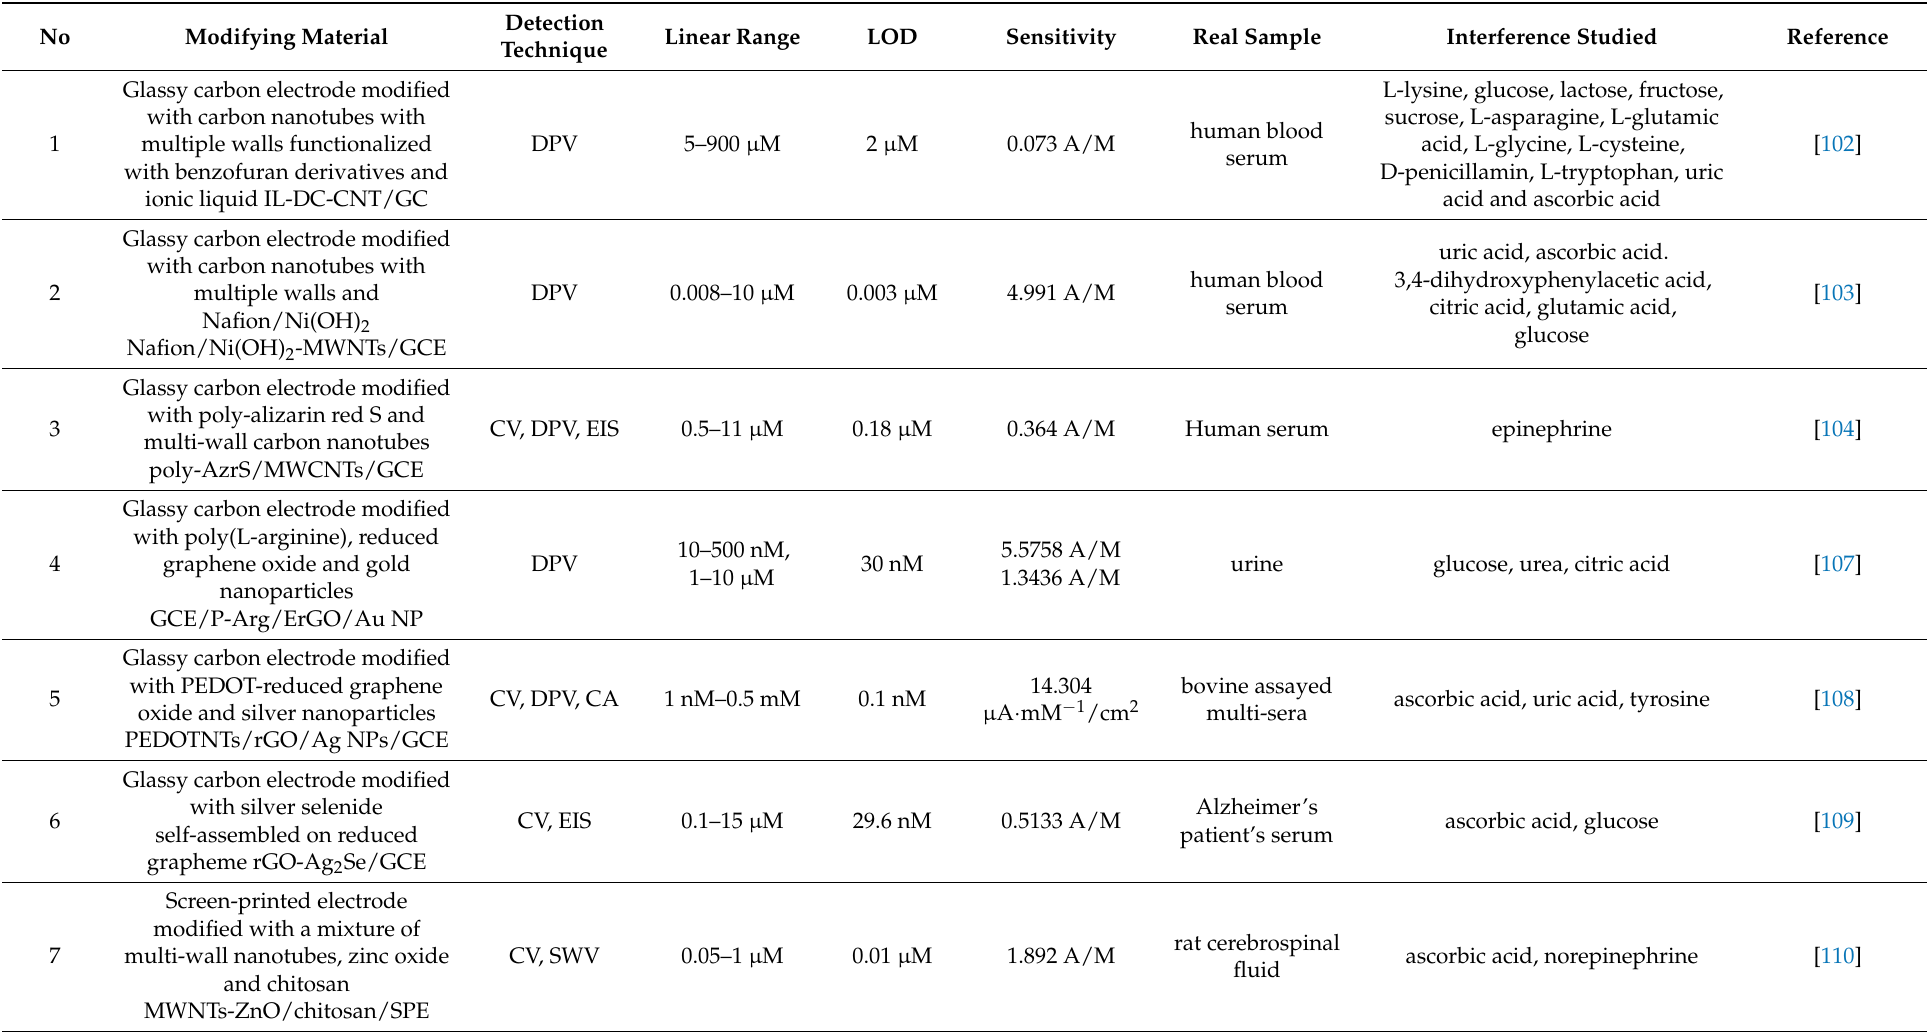
Table 1. Electrochemical sensors used for serotonin